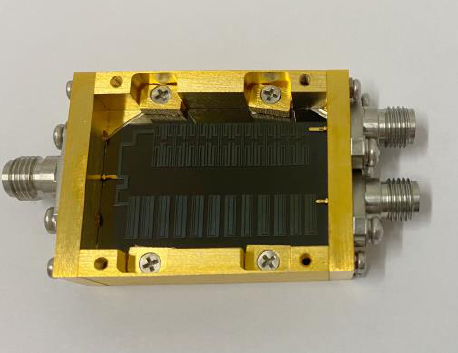
Figure 12. Fabricated HTS diplexer.